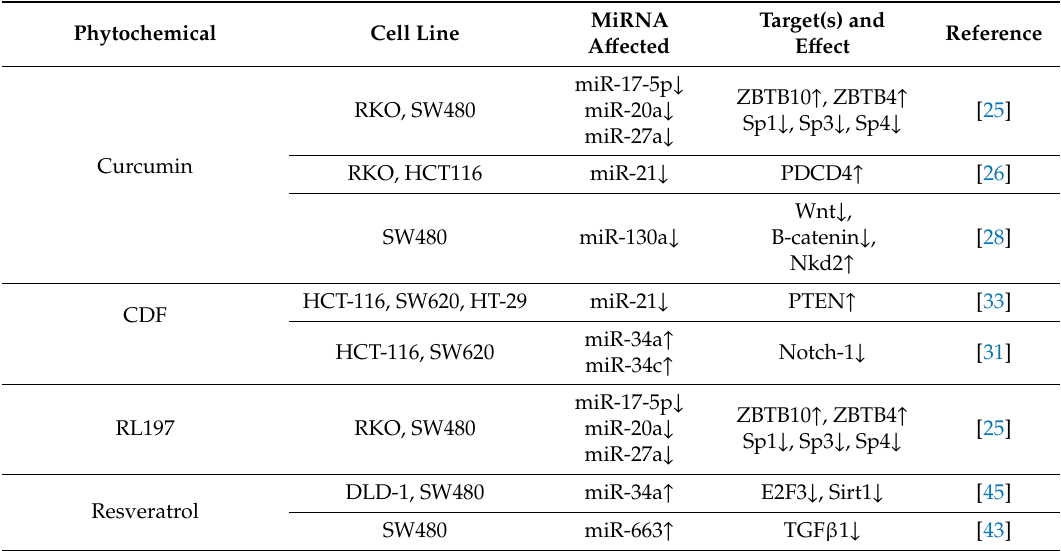
Figure 1. In vitro e ff ect of phytochemicals against colorectal cancer by modulation of micro-RNA. Black arrows indicate upregulation while blunted black bars indicate downregulation of selected miRNA by phytochemicals. Overall phytochemical modulation of miRNAs exerts anti-tumorigenic e ff ects either by inhibition of metastasis and invasion, inhibition of cell growth and proliferation, or induction of apoptosis. OncomiRs are shown in red boxes and are downregulated by phytochemicals, while tsmiRs are shown in blue boxes and are upregulated by phytochemicals. Table 1. In vitro e ff ect of phytochemicals against colorectal cancer by miRNA